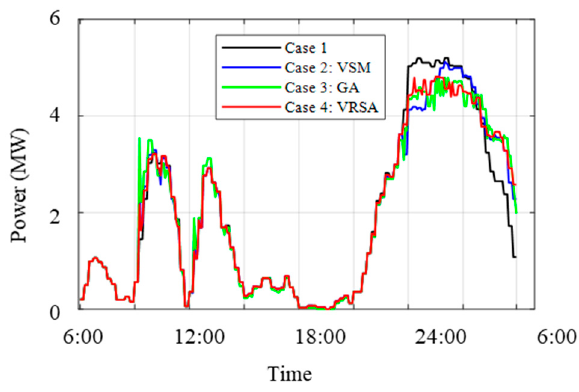
Figure 10. The aggregated CL power of the four cases.